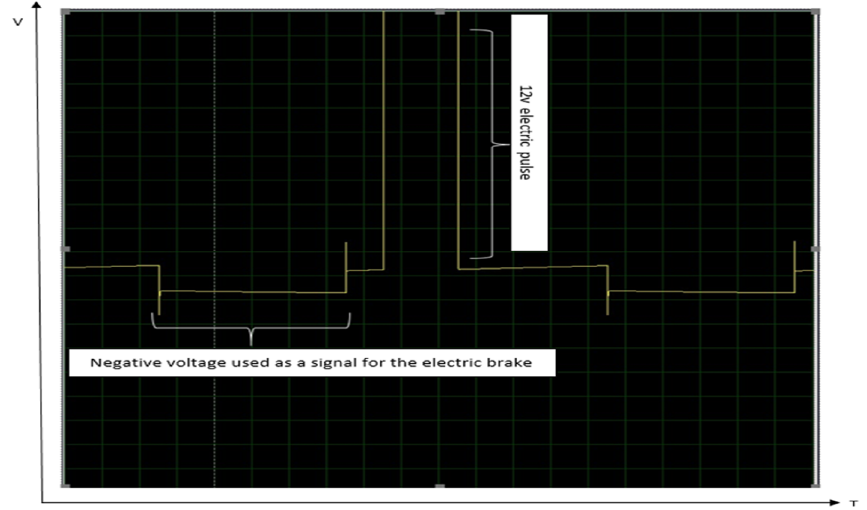
Figure 9. Inductive effect of the motor when power source is disconnected at a scale of 1-volt. As seen in Figure 10, the peak voltage is relatively low, approximately −2-volt as a peak at disconnection and −1-volt for a period of 3 s before experiencing another peak of tension at the connection of approximately 2.2-volt, all due to inductive loads.